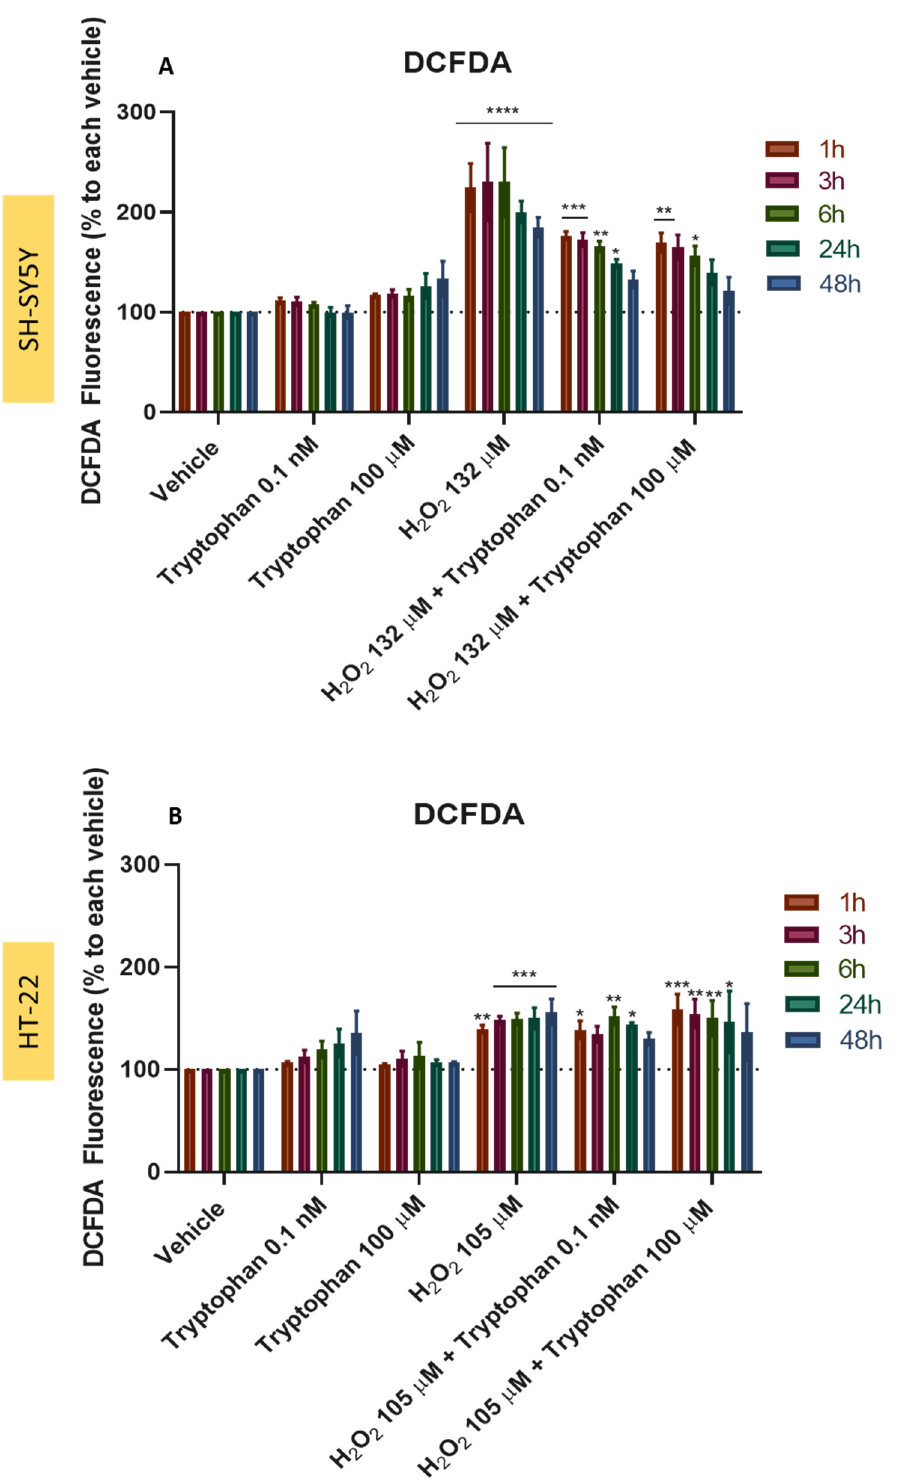
Figure 20. Effect on ROS production of 1 h, 3 h, 6 h, 24 h, and 48 h-incubation of ( A ) 132 µ M of H 2 O 2 , 0.01 µ M/100 µ M of L-tryptophan and 132 µ M of H 2 O 2 + 0.1 nM/100 µ M of L-tryptophan (SH-SY5Y cells) and ( B ) 105 µ M of H 2 O 2 , 0.1 nM/100 µ M of L-tryptophan and 105 µ M of H 2 O 2 + 0.1 nM/100 µ M of L-tryptophan (HT-22 cells), determined by DCFDA assay. The results represent the mean ± SEM of 2–6 independent experiments, expressed as the percentage of each vehicle (100%) for each period. Statistically significant * p < 0.05, ** p < 0.01, *** p < 0.001, and **** p < 0.0001 vs. vehicle, for each time.